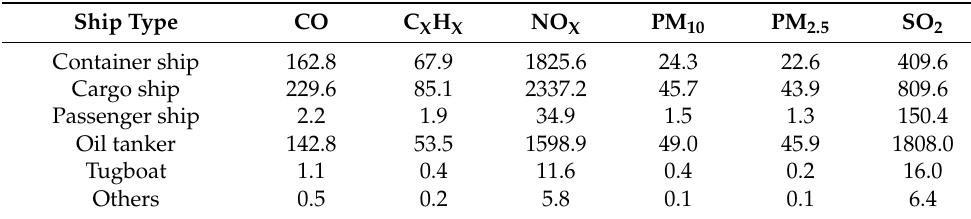
Table 10. Pollutant emissions by ship types in the Port of Los Angeles (unit: ton).